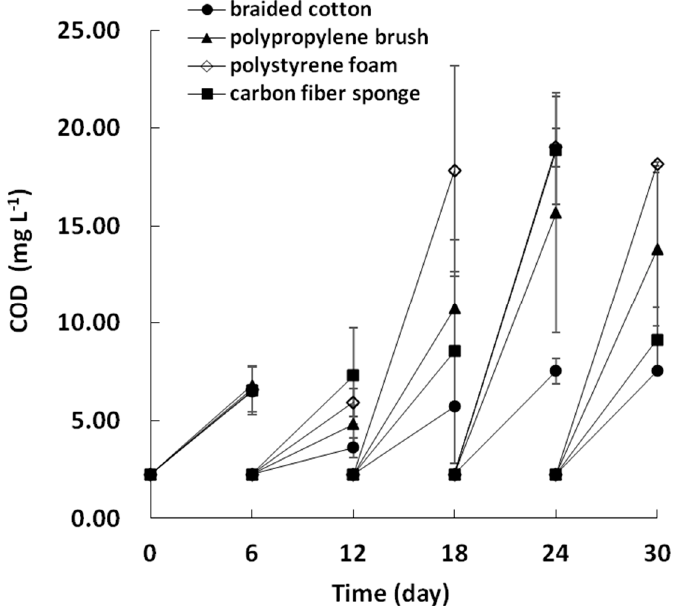
Figure 6. COD value in the bioremediation test with different biofilm carriers (Error bars represent the standard deviation, N = 2).